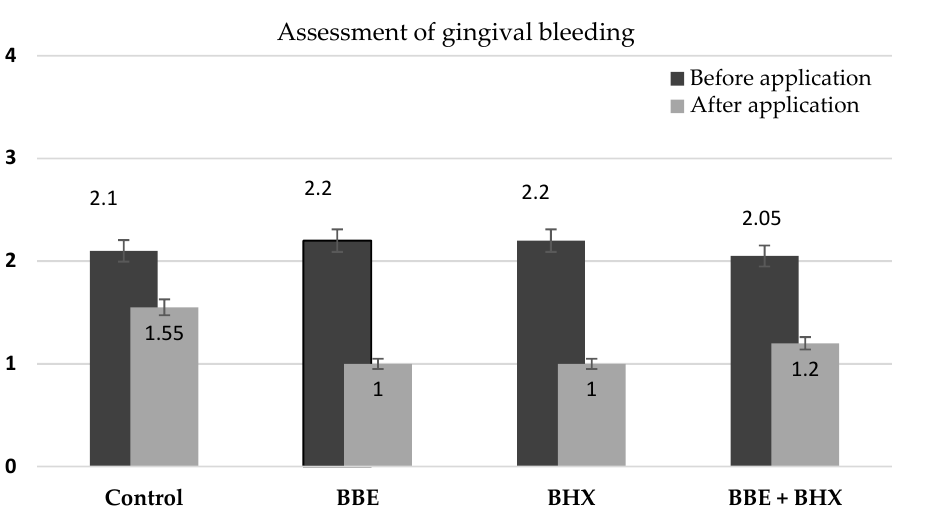
Figure 5. The graph represents the level of gingival bleeding before and after application of tested solutions. Control — patients treated with saline solution; BBE — patients treated with beech bark ex- tract; CHX — patients treated with chlorhexidine; BBE + CHX — patients treated with beech bark ex- tract and chlorhexidine (ratio 1:1).